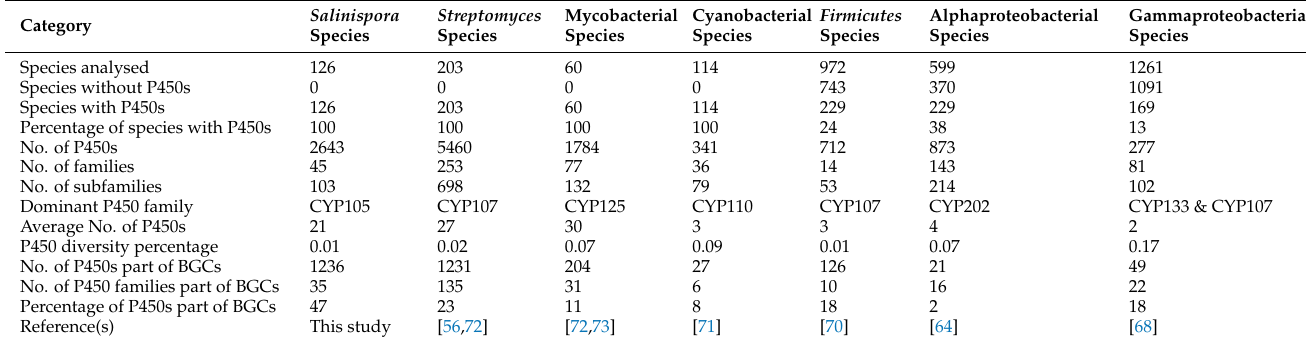
Table 1. Comparative analysis of key features of P450s and their association with secondary metabolism between Salinispora species and different bacterial species. Abbreviation: No., number of; BGCs: biosynthetic gene